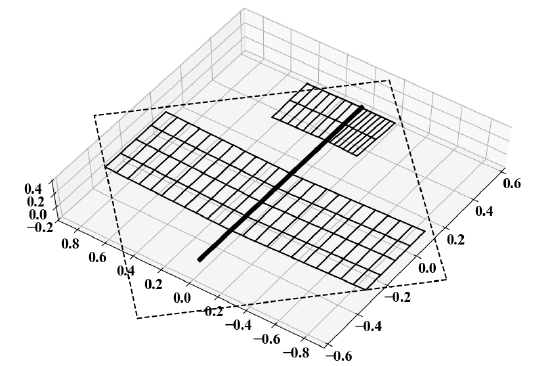
Figure 29. Optimal aircraft planform using b-spline functions for control